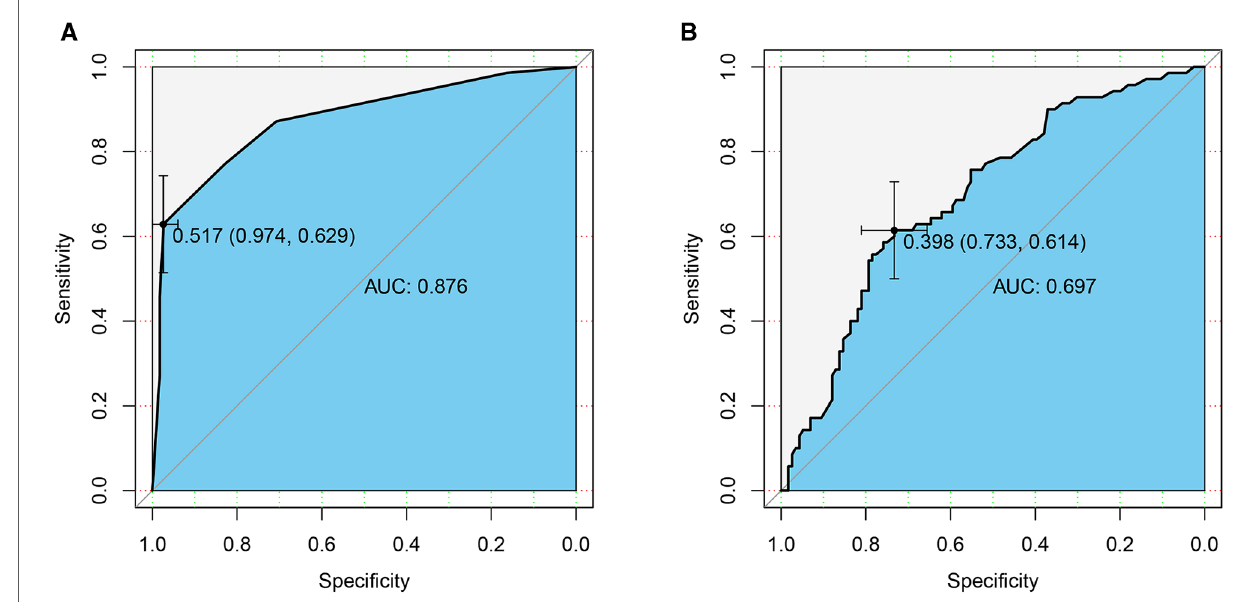
FIGURE 1 ROC curves of the prediction models. ( A ) Pathological features; ( B ) CT signs. AUC, area under the